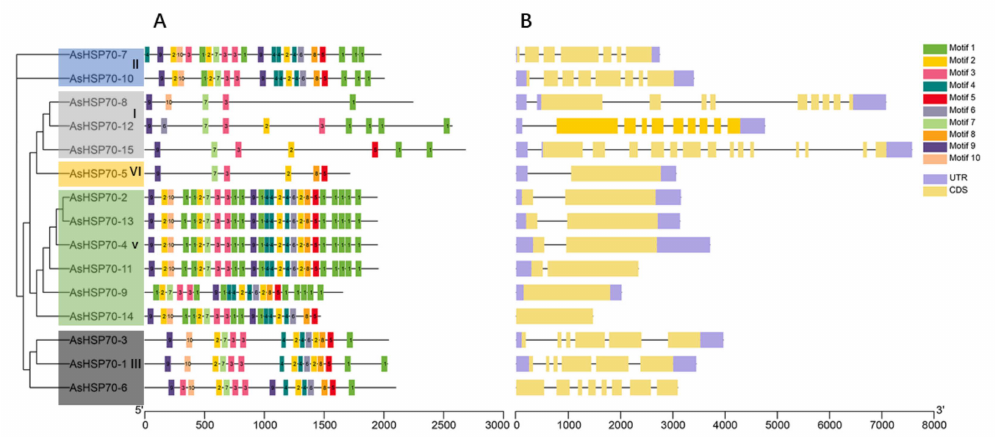
Figure 4. Distribution of conserved motifs and gene structure of the AsHSP70 . ( A ) Conserved motifs analysis of AsHSP70 proteins using MEME tools. Conserved motifs are shown in different colored boxes. ( B ) Exon–intron organization of AsHSP70 genes. Yellow boxes represent exons and black lines represent introns. The untranslated regions (UTRs) are indicated by purple